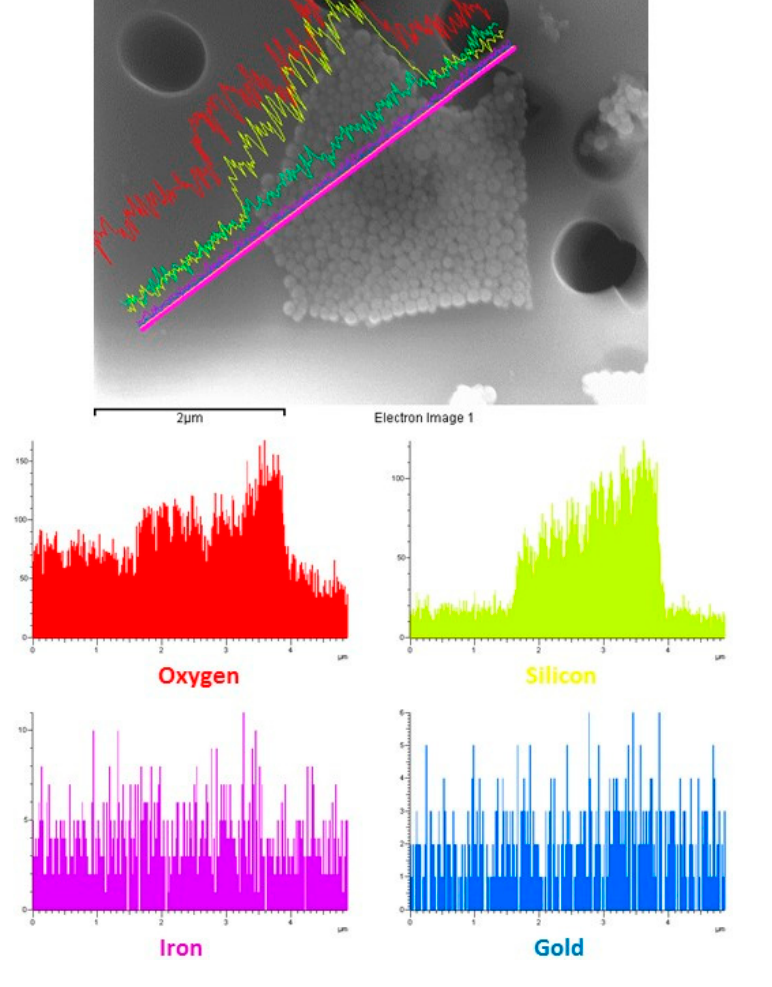
Figure A1. Nanoparticles (NP).